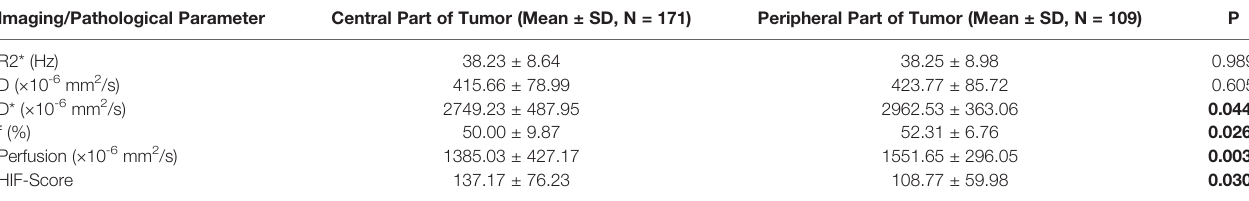
TABLE 2 | Mean parameter values for the spatial distribution of pathological and imaging features. Imaging/Pathological Parameter Central Part of Tumor (Mean ± SD, N = 171) Peripheral Part of Tumor (Mean ± SD, N =